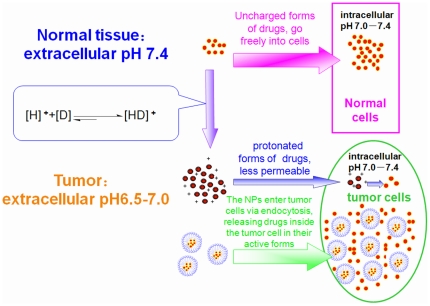
The cause of PIPDR and the reversion of PIPDR by NPs. [D] stands for drugs and [H]+ stands for the proton.